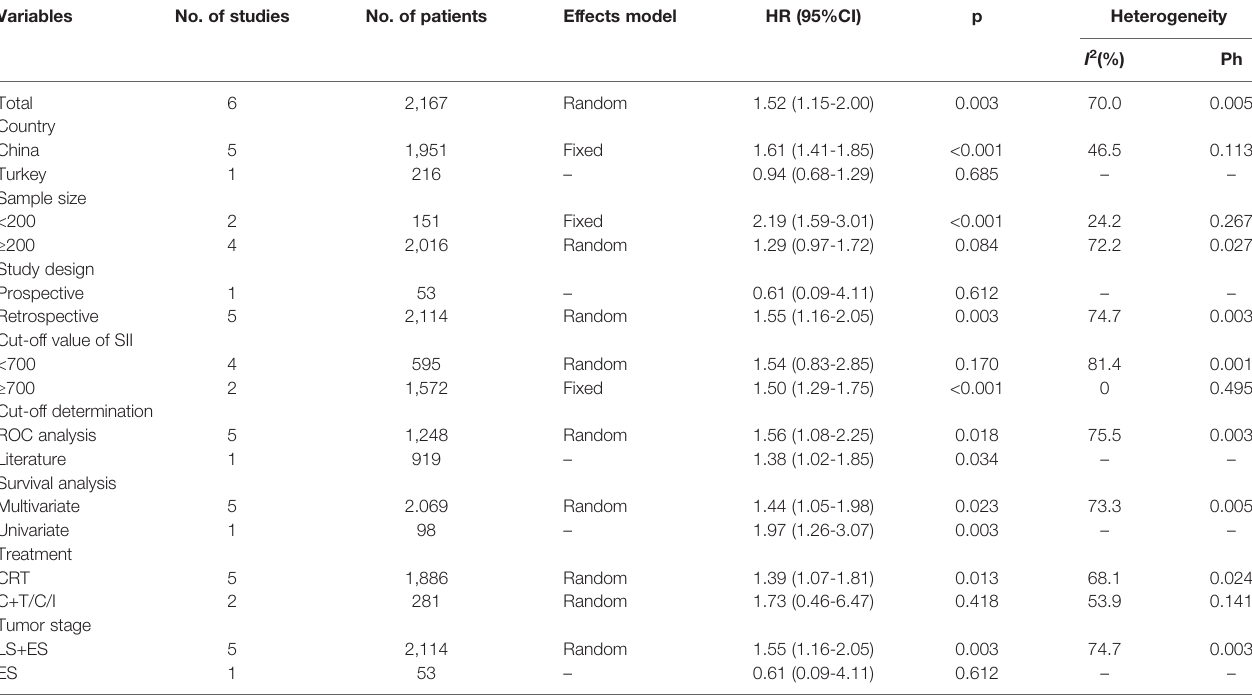
TABLE 2 | Subgroup analysis of the prognostic value of SII for overall survival in patients with SCLC.